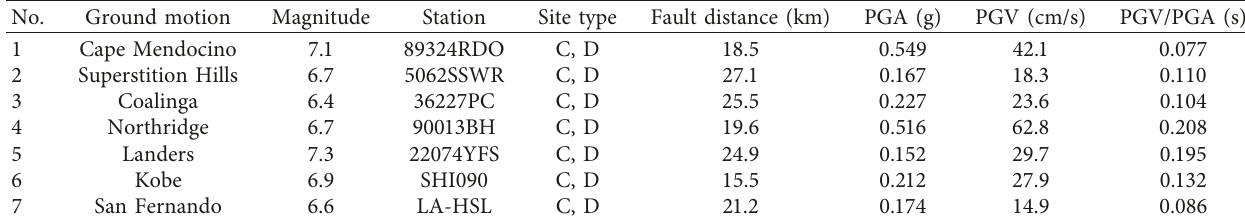
Table 3: Parameters of far-field seismic